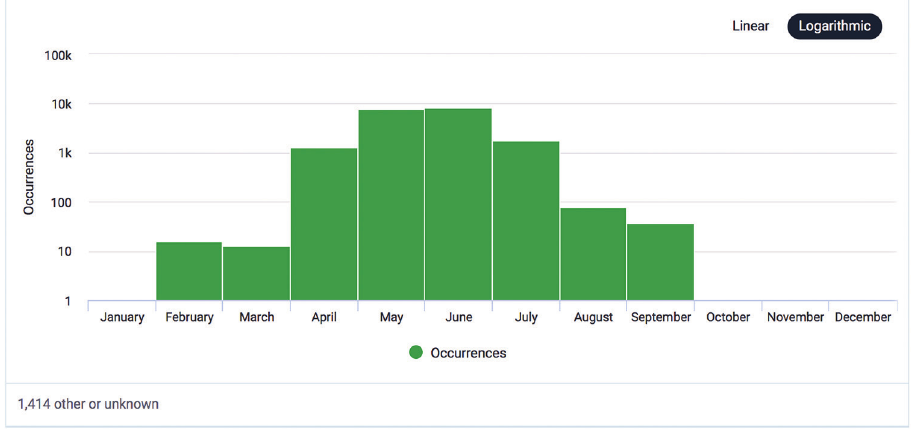
Figure 3. Temporal coverage of the “Segetal flora of Italy” dataset (occurrences per